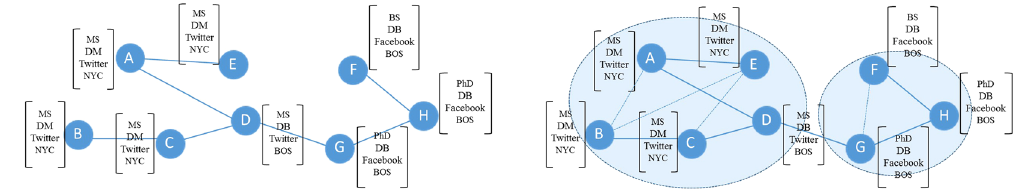
Figure 1. An illustrated example of k